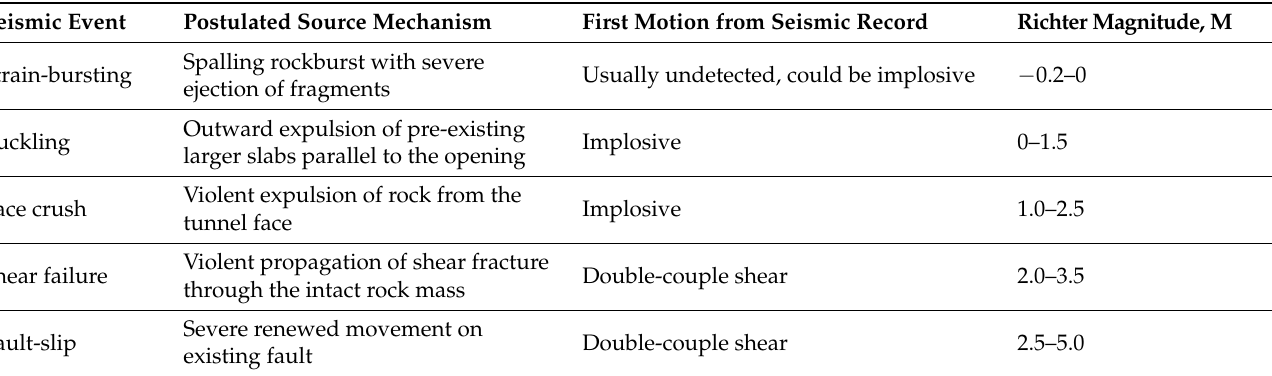
Table 2. Classification of rockbursts [17].